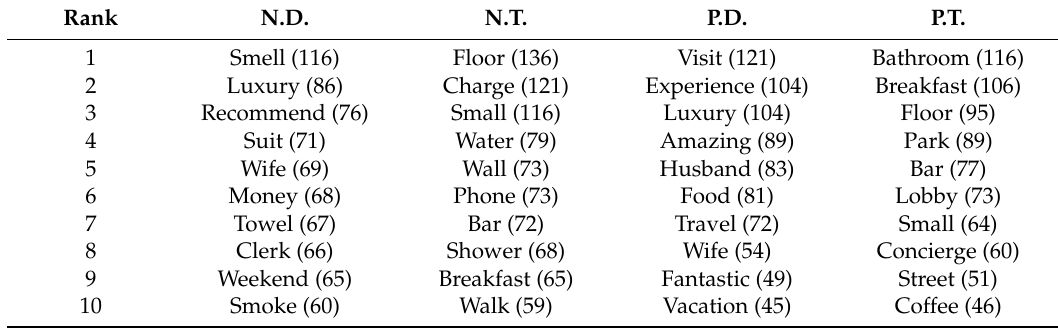
Table 1. The top 10 distinct words used by deceptive and truthful hotel reviews. N.D.: term occurring in negative deceptive reviews; N.T.: term is occurring in negative true reviews; P.D.: term is occurring in positive deceptive reviews; P.T.: term is occurring in positive true reviews.